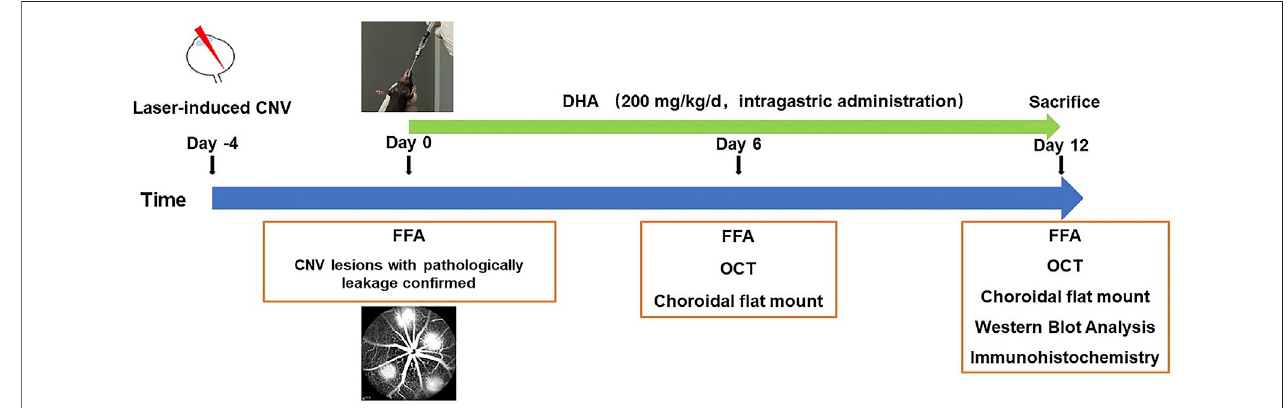
FIGURE 1 | Experimental schedules to evaluate the effect of DHA on laser-induced choroidal neovascularization CNV in a mouse model. After fl uorescein angiographycon fi rmedthatCNVwasinduced,DHAorvehiclewasintragastricallyadministeredonceaday for12continuous days.CNV,ChoroidalNeovascularization; DHA: Dihydroartemisinin; FFA: Fundus Fluorescein Angiography; OCT: Optic Coherence